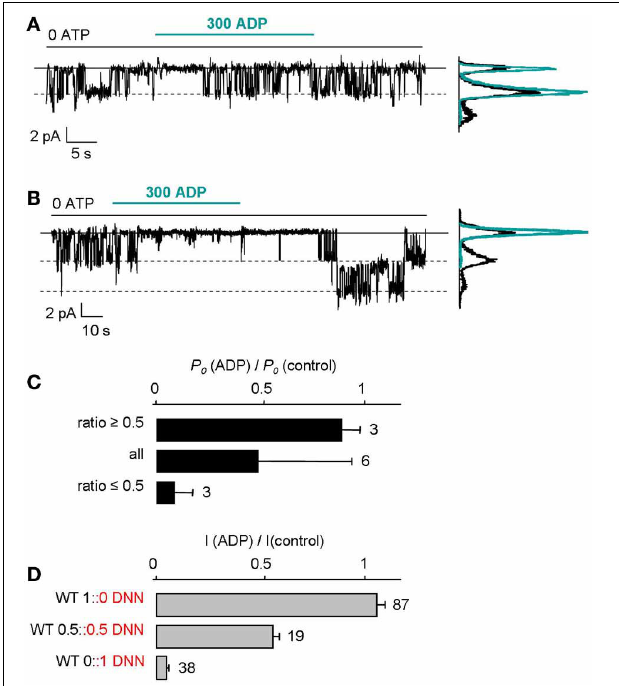
FIGURE 2 | All-or-none responses of single K ATP channels to MgADP. (A,B) Recordings of single K ATP channels in inside-out patches excised from oocytes injected with 0.02 ng of Kir6.2 RNA and 0.03 ng each of WT and mutant SUR2A RNAs. Compared to macroscopic current experiments, the amount of RNA injected was reduced 100-fold and smaller patch pipettes were used to lower the channel density toward 1 per patch. Amplitude histograms computed from the current records before (black) and ∼ 10s after (green) ADP application. (C) Using records as in (A) and (B) , the ratios of the open probabilities (Po) measured after and before ADP application were calculated from amplitude histograms and revealed 2 clusters near 1 (as in A where ratio was 0.86) and near 0 (as in B where ratio was 0.03). The histogram plots average values of the ratio using either all values, or values above 0.5, or values below 0.5. (D) Mean effect of 300 µ M ADP on macroscopic currents from WT, mutant, and an equal mix of WT and mutant channels. Numbers beside bars indicate the number of patches included in the averages.